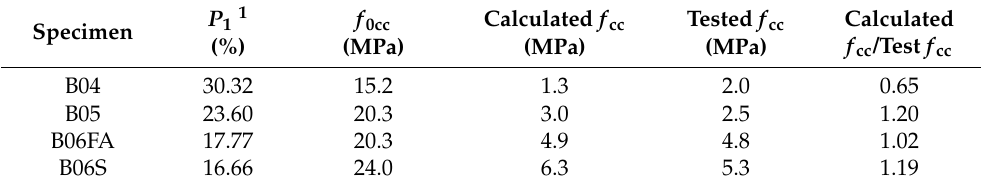
Table 9. Comparison of calculated and tested values of compressive strength with different porosity. Specimen